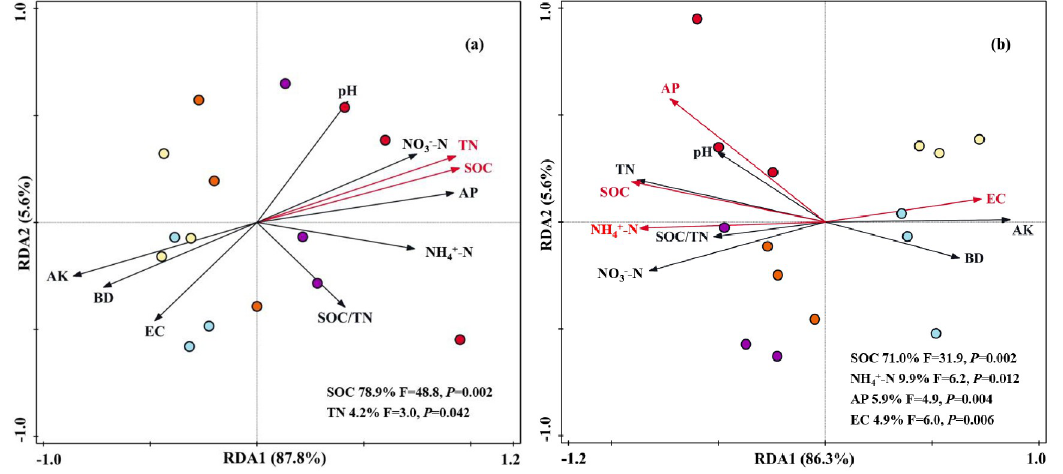
Fig 7. Redundancy analysis (RDA) of soil enzyme activities (a), microbial community structure (b) constrained by soil physicochemical properties under different fertilization treatments.